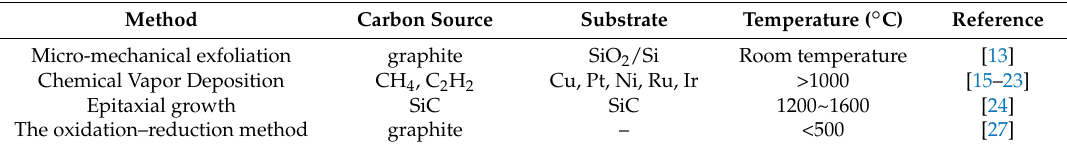
Table 1. Different methods for graphene synthesis.